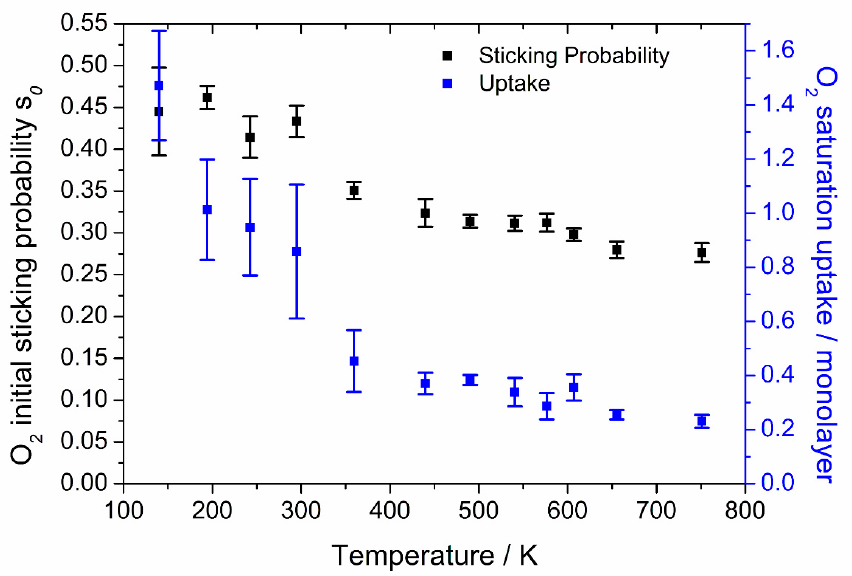
Figure 3. Initial sticking probability of oxygen and saturation coverage (in atoms), as a function of crystal temperature.